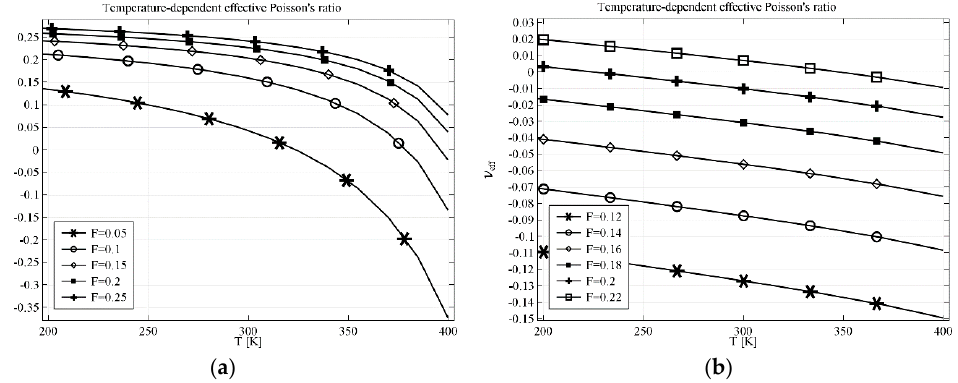
Figure 5. Effective Poisson’s ratio for RH (re-entrant honeycomb) geometry with linking elements in the case of ( a ) computational linking material; ( b ) real linking material. Parameters of the geometry: L = 1, B = 0.1, D = 0.15, G = 0.25, F —variable parameter.